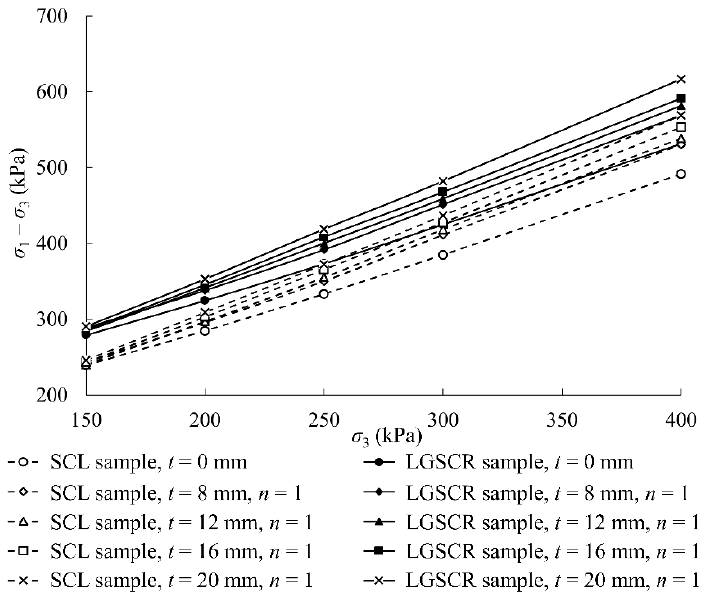
Figure 13. The peak stress–confining pressure curves of the samples at different thicknesses of sand layers.